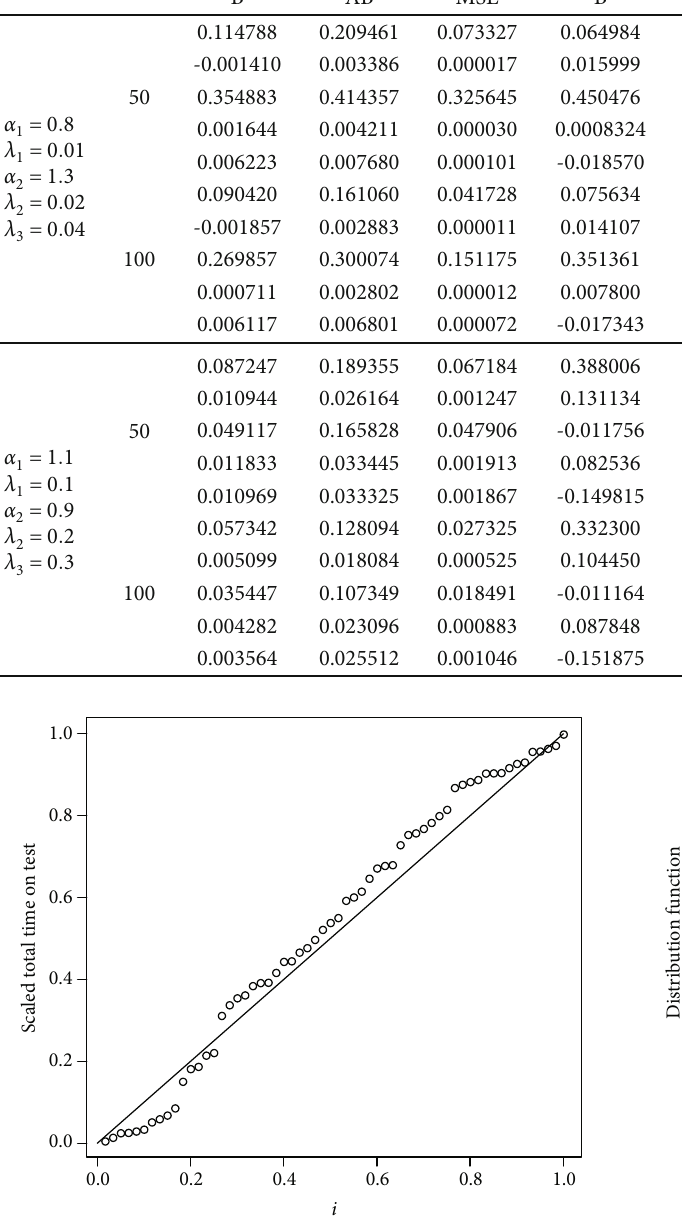
, λ , α , λ , and λ from top to 1 1 2 2 3